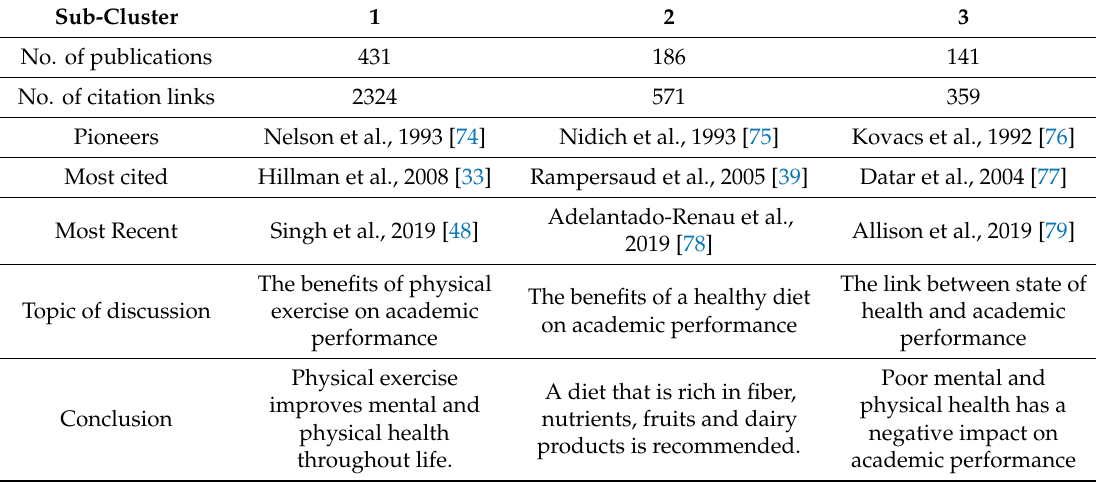
Figure 18. Group 2-subclusters citation network. Table 5. The most important subclusters from group 2.